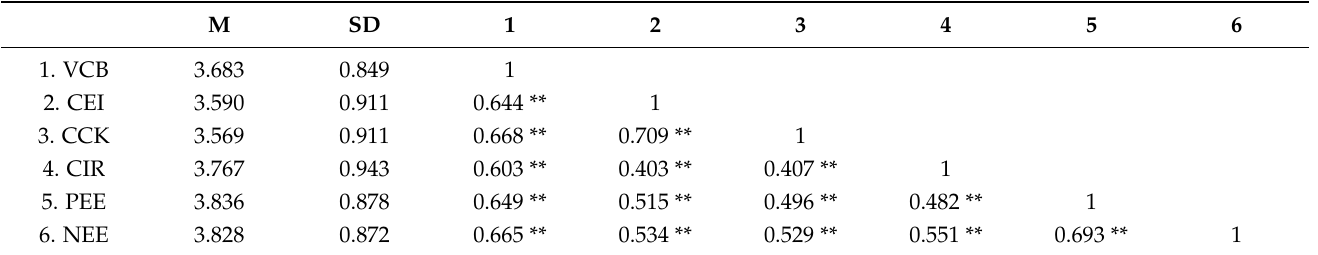
Table 5. Descriptive statistics and correlation matrix for all variables.